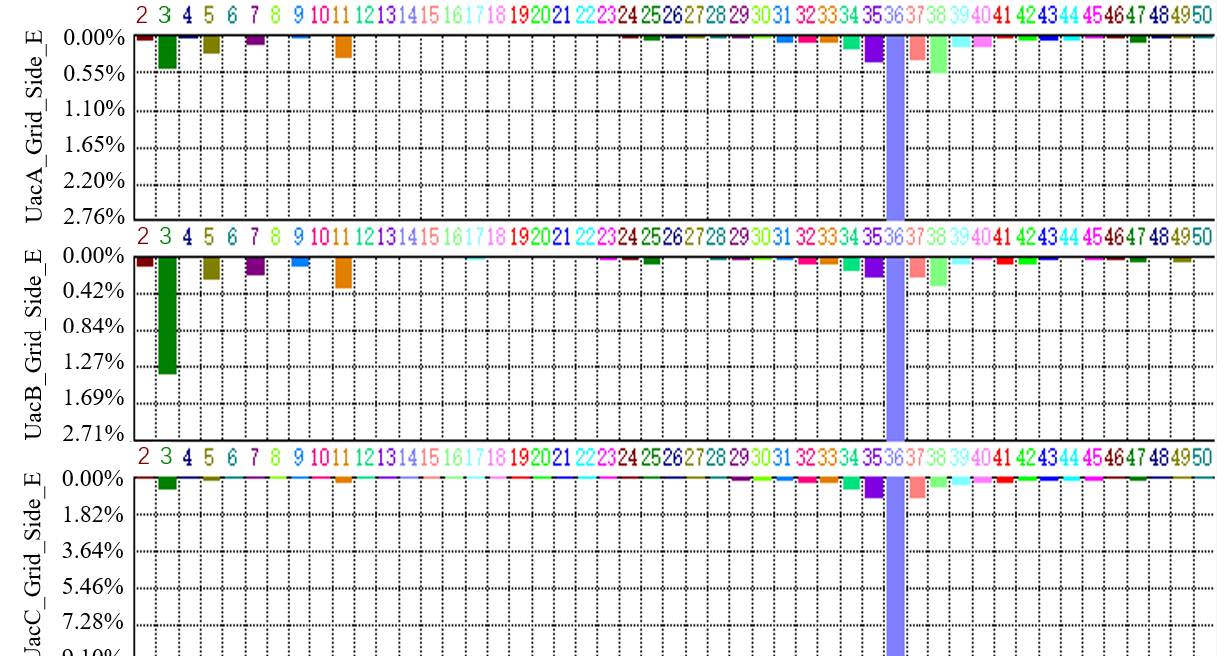
Figure 2. Waveform of high-frequency oscillation.